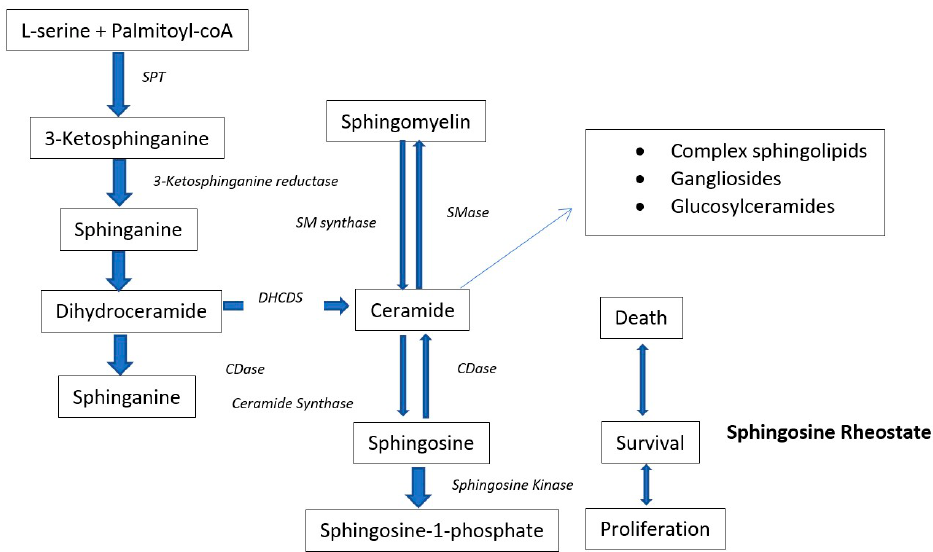
Figure 1. Schematic presentation of the de novo biosynthesis of ceramide and ceramide metabolism. SMase, sphingomyelinase; CDase, ceramidase; SM synthase, sphingomyelin synthase. (Modified from: Brozinick, Hawkins [87]).